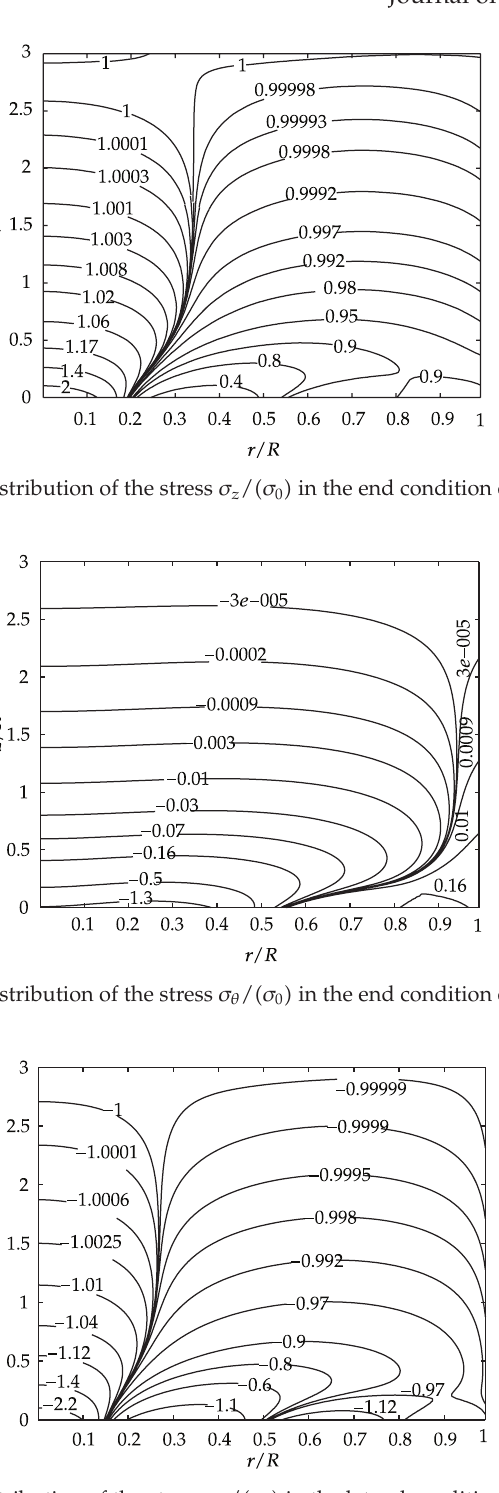
Figure 5: Distribution of the stress σ r / (cid:6) σ 0 (cid:7) in the lateral condition